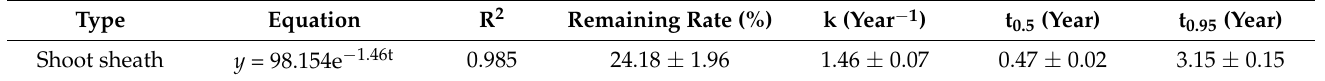
Table 4. Regression analysis between dry weight residue of litter and